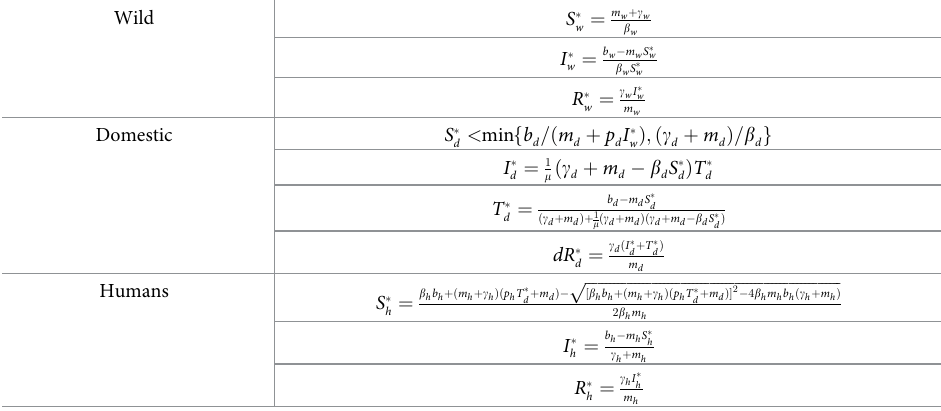
Table 4. The endemic equilibria values in each species compartment. A proof of the uniqueness of the equilibrium value S � is in S1 d